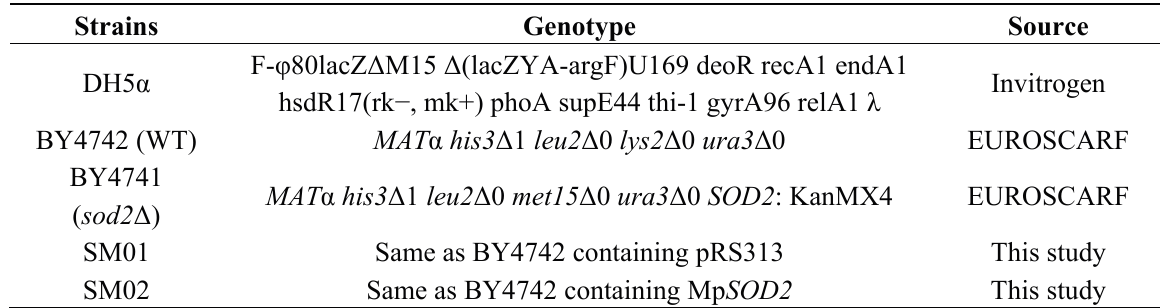
Table 1. Bacterial and yeast strains used in this